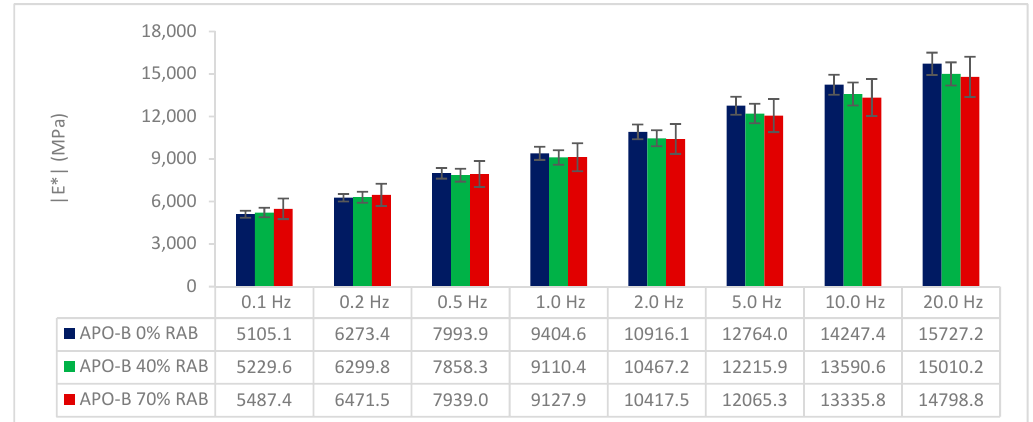
| E* | modulus of the three mixtures under various Figure 4. |E*| modulus of the three mixtures under various frequencies. Figure 4.